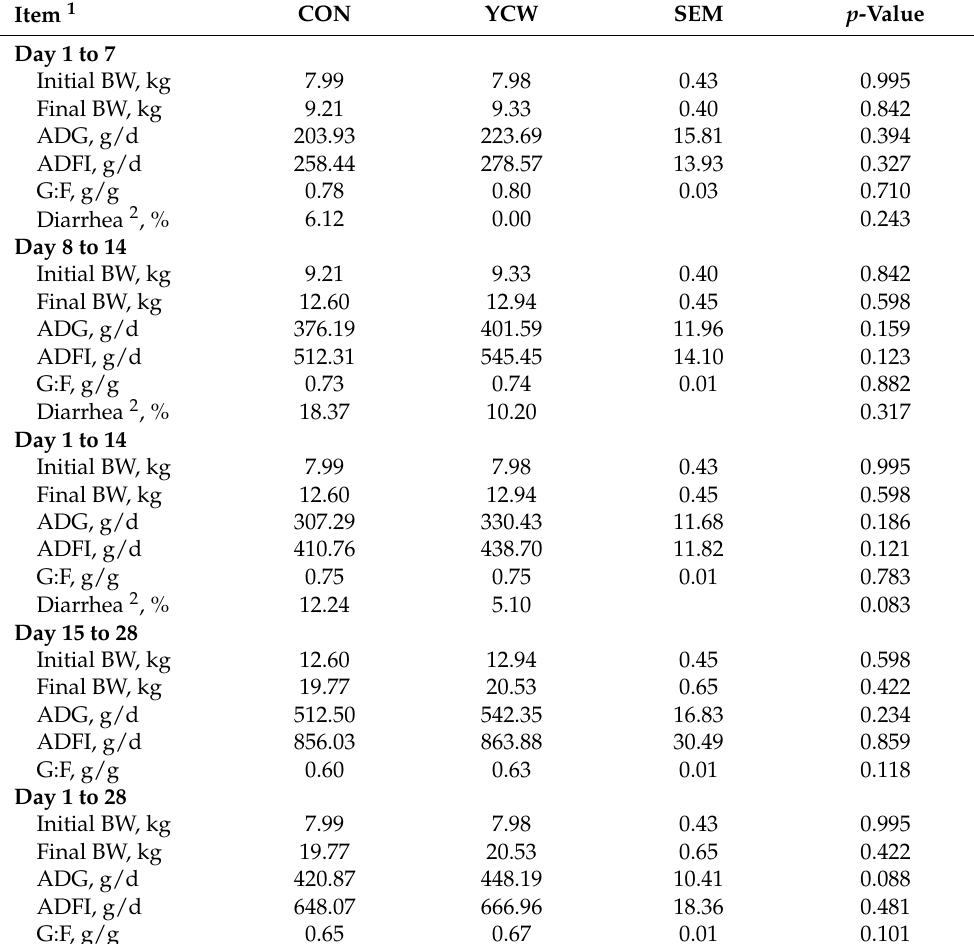
Table 3. Growth performance of weaned pigs fed diets with or without dietary yeast cell wall.